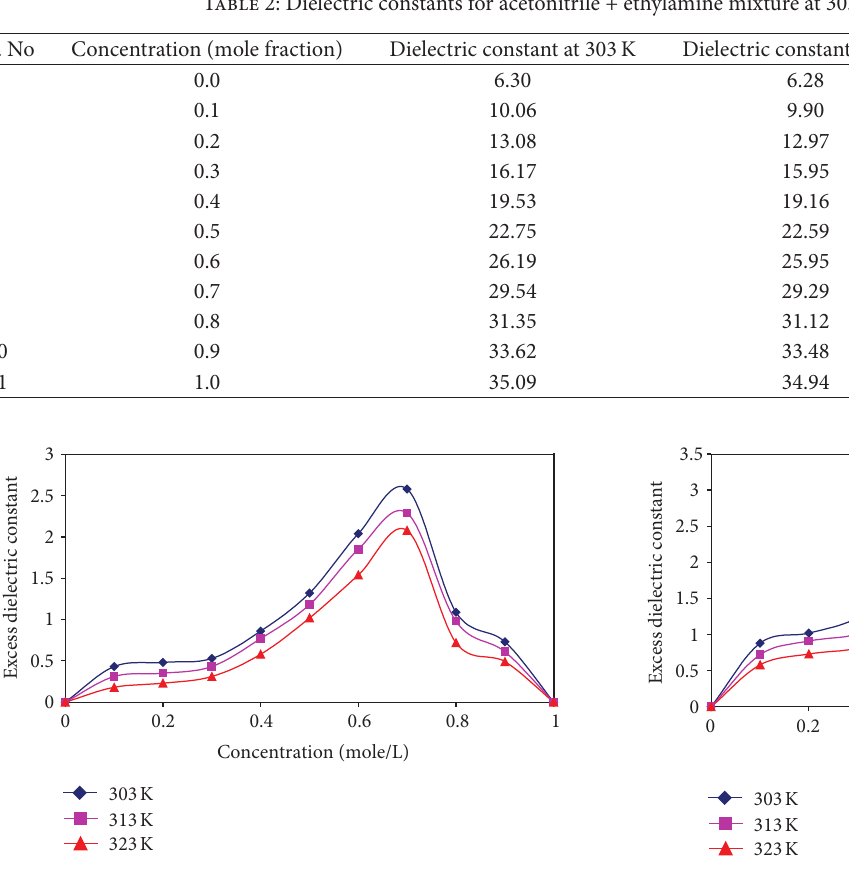
F 2: Excess dielectric constant for acetonitrile + ethylamine mixture versus concentration at 303, 313, and